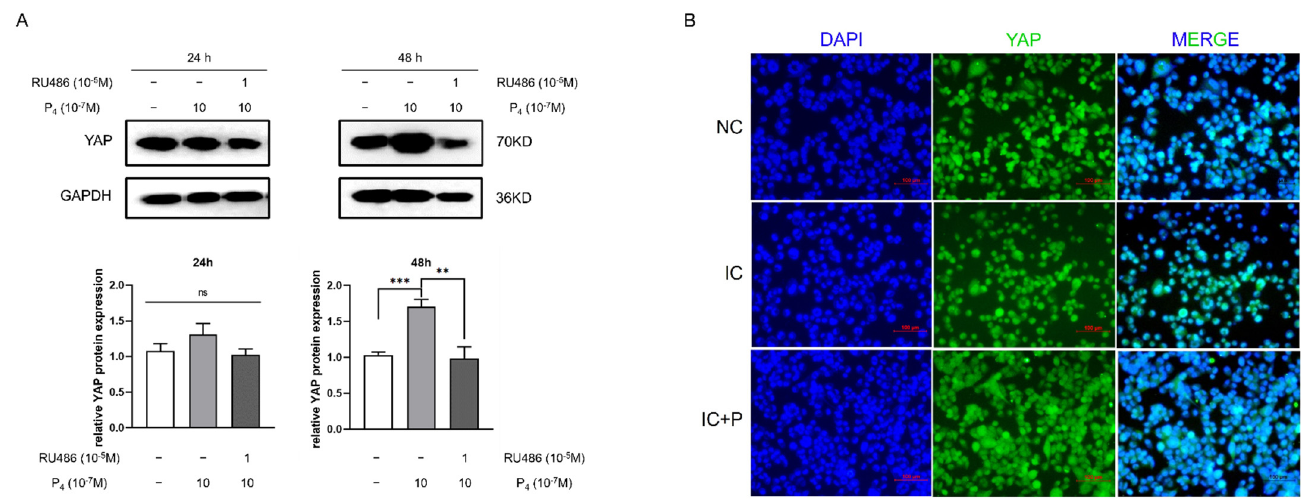
Figure 2. Progesterone regulates the expression of YAP in HTR-8 cells. ( A ) Progesterone enhances the expression of YAP and is partly reversed by RU486 in HTR-8 cells. HTR-8 cells were treated with control vehicle (DMSO) or progesterone (P 4 ) (10 − 6 M), alone or in combination with RU486 (10 − 5 M), for 24 h or 48 h. The YAP protein expression in each group was analyzed by immunoblotting and GAPDH served as internal control. The results of quantification are presented as the mean ± SEM. One-way ANOVA test; ns indicates nonsignificant, ** p < 0.01, *** p < 0.001. ( B ) Pre-treatment of P 4 (10 − 6 M) for 24 h promotes nuclear translocation of YAP in HTR-8 cells administrated by anti- β 2GPI- IgG (1 µ g/mL)/ β 2GPI (10 µ g/mL). Scale bars, 100 µ m. NC, control; IC, the anti- β 2GPI-IgG/ β